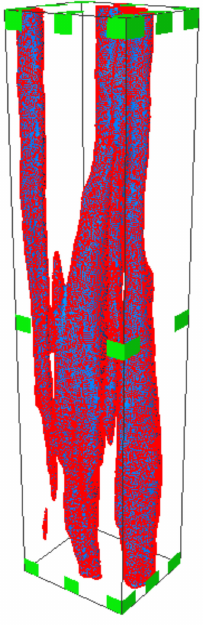
Figure 4. Surface mesh.